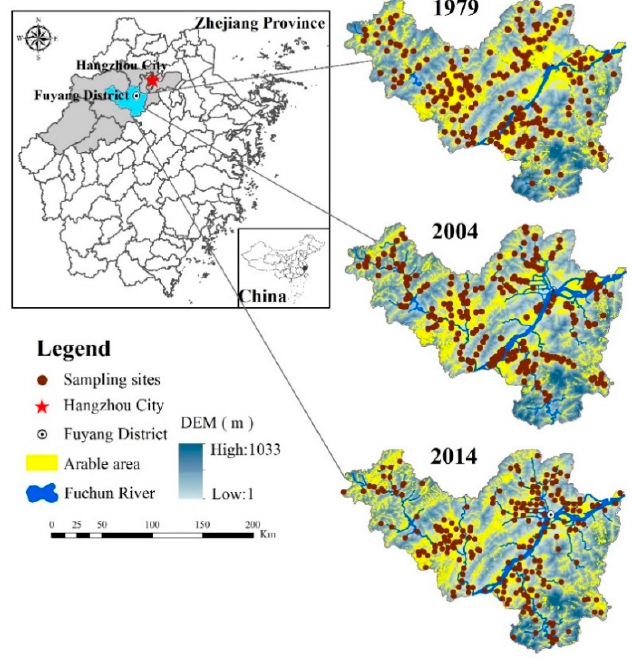
Figure 1. Map of the study area and locations of the sampling sites in 1979, 2004 and 2014.